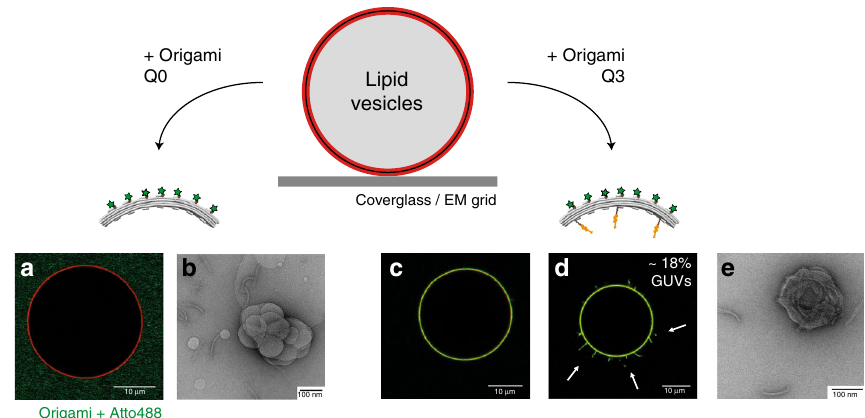
Fig. 2 Binding of curved origami structures to lipid model membranes. Interaction of the BAR-mimicking curved origami structures (labeled with Atto488; green) with DOPC model membranes (labeled with DOPE-Atto655; red) assessed using confocal microscopy and TEM. Bare DNA origami nanostructures (Q0) did not interact with GUVs, as observed on GUVs imaged at the equatorial plane by confocal microscopy ( a ) and on MLVs by negative-stain TEM ( b ). Incorporation of three TEG-chol moieties at the distal 5 ′ -end of 18 bps-long linker sequences extending from the origami backbone (structure Q3), rendered optimal binding of the DNA origami structures to lipid bilayers ( c , e ). After incubation for at least 1 h with origami structure Q3 ( d ), circa 18 % of the GUVs presented outwards lipidic tubules (marked by arrows). Scale bars: ( b , e ) 100 nm; ( a , c , d ) 10 µ